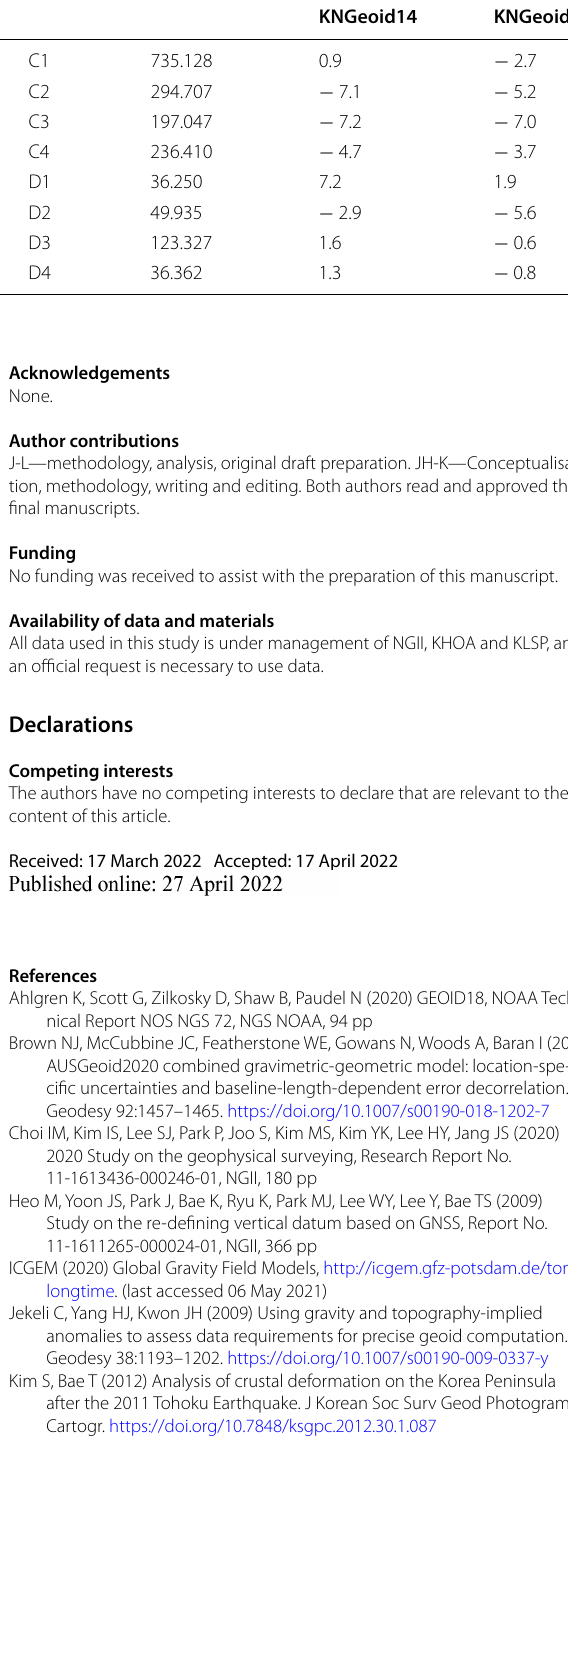
Table 3 Geoidal height differences among KNGeoid18, KNGeoid14, and 16 points of new GNSS/Leveling data in the mountainous areas